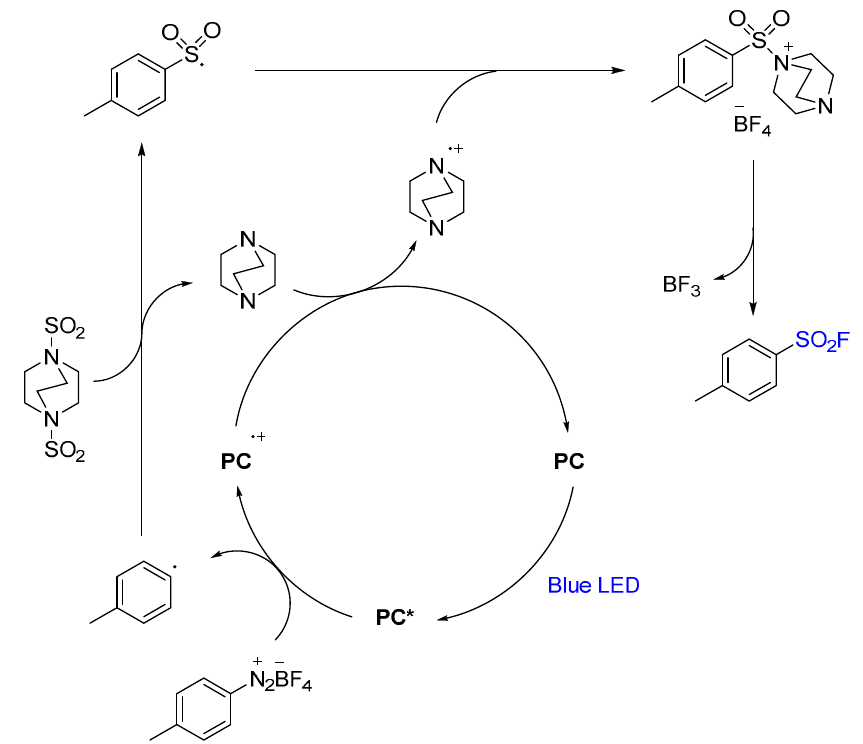
Scheme 13. Proposed mechanism for the visible-light synthesis of arysulfonyl fluorides.